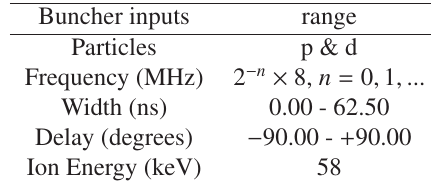
Table 2. List of Buncher inputs that can be selected and their